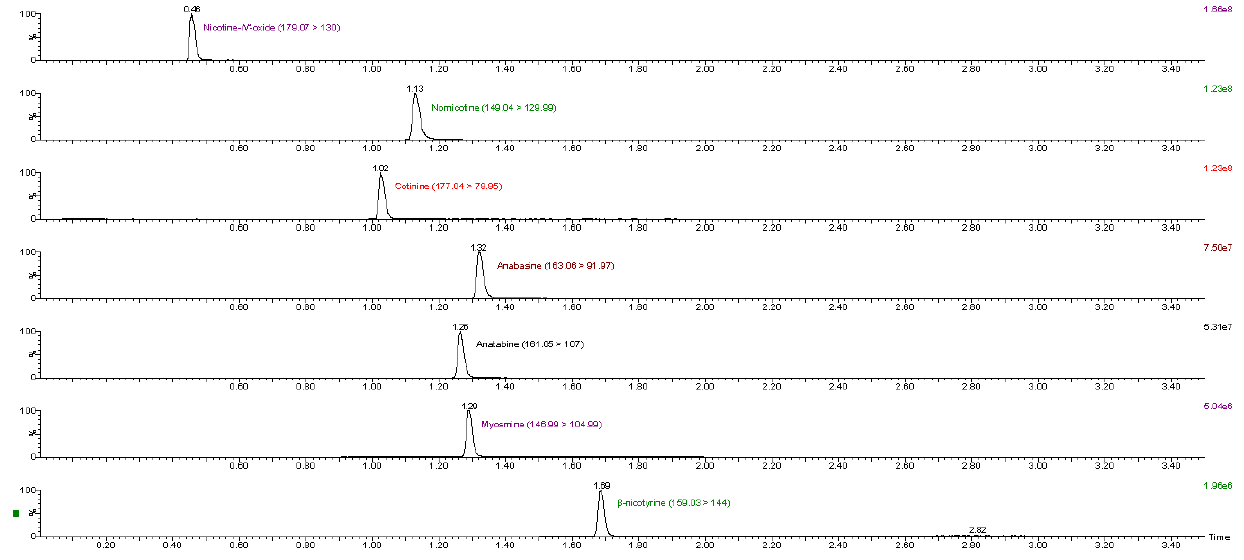
Figure 1. MRM transitions for all analytes in calibration standard